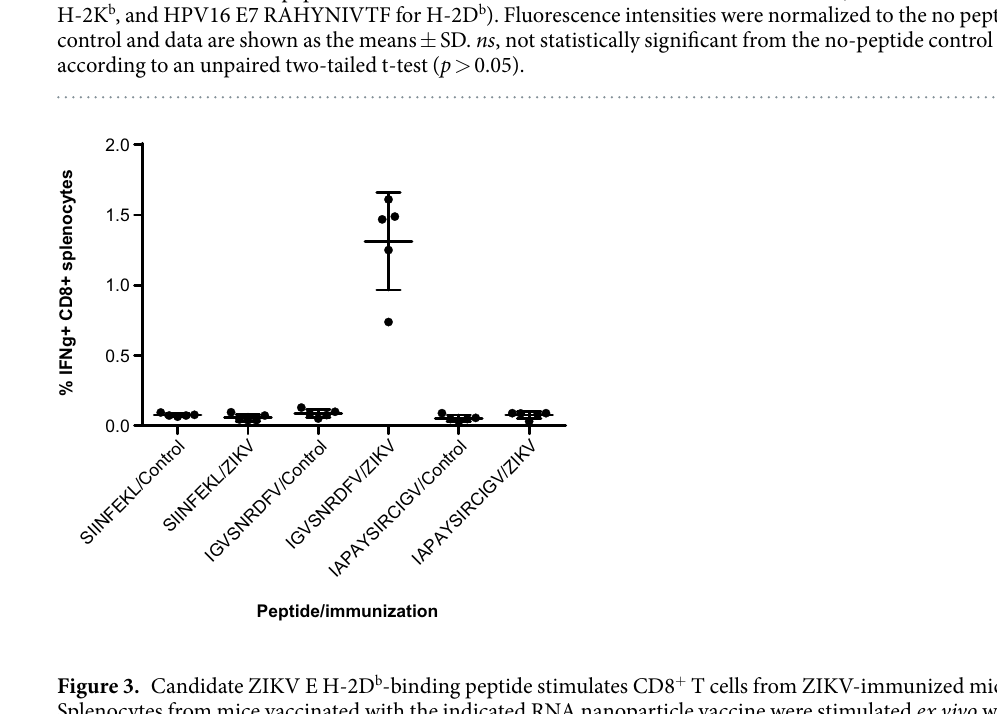
Figure 3. Candidate ZIKV E H-2D b -binding peptide stimulates CD8 + T cells from ZIKV-immunized mice. Splenocytes from mice vaccinated with the indicated RNA nanoparticle vaccine were stimulated ex vivo with 0.2 μ g/mL of the indicated peptide. After 7 h, intracellular cytokine staining for IFN γ was performed and measured by flow cytometry. Error bars represent SD, and N = 5 animals per